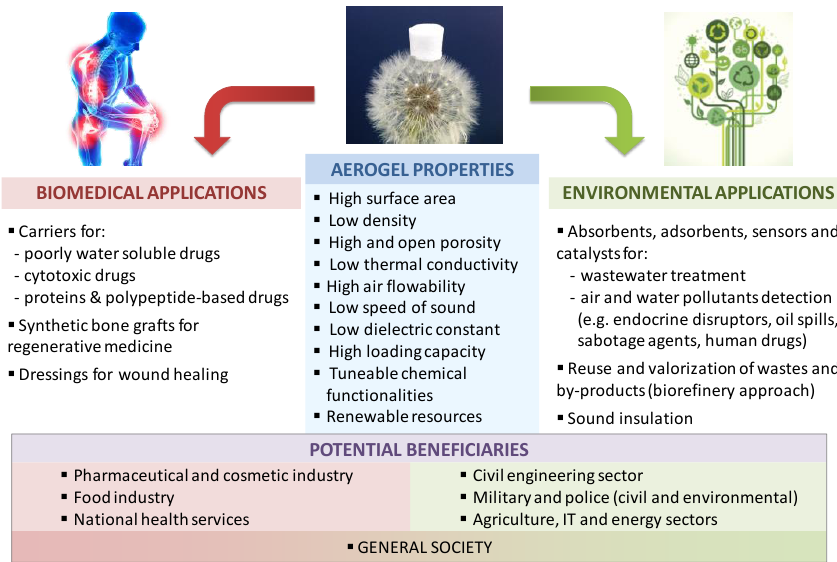
Figure 1. Outlook of advanced biomedical and environment applications of aerogels susceptible of being prospected in the future. Adapted from [31].